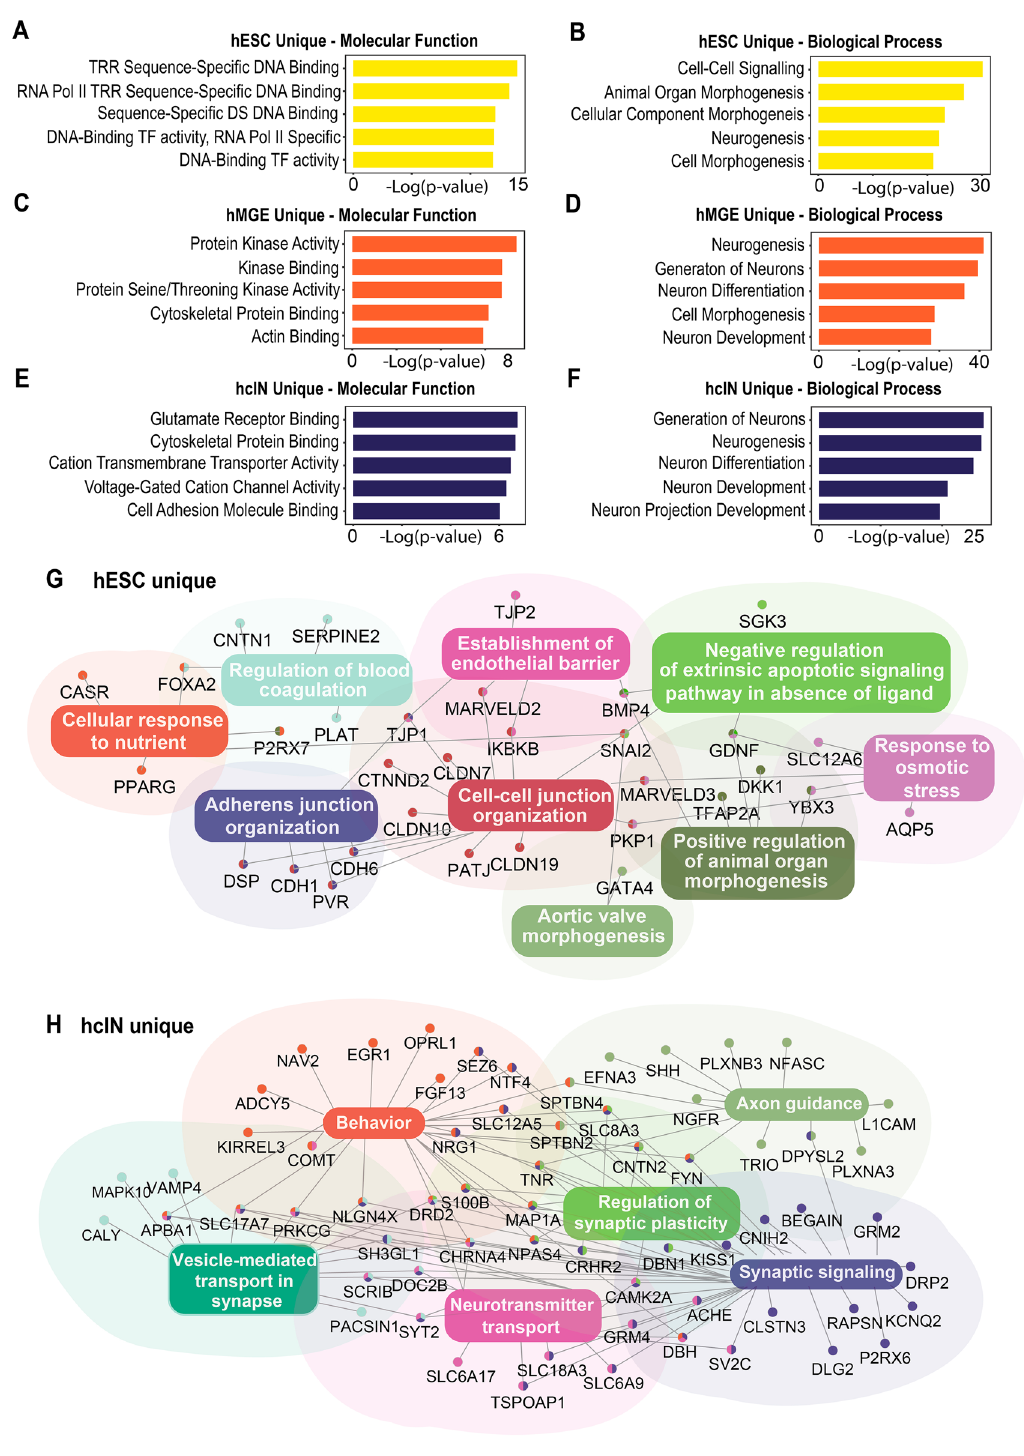
Figure 2. Analysis of genes associated with CHD2 binding during hcIN differentiation. ( A – F ) Gene ontology (GO) enrichment analysis of genes with a promoter proximal CHD2 peak uniquely in ( A , B ) hESCs, ( C , D ) hMGEs, or ( E , F ) hcINs. − Log10 p values for top enriched terms are shown. ( G , H ) Gene networks generated from a single representative GO term. In ( G ), the hESC ‘unique’ CHD2-bound gene network was generated by focusing on intracellular junction-related genes. In ( H ), the hcIN ‘unique’ CHD2-bound gene network was generated by focusing on synapse-related